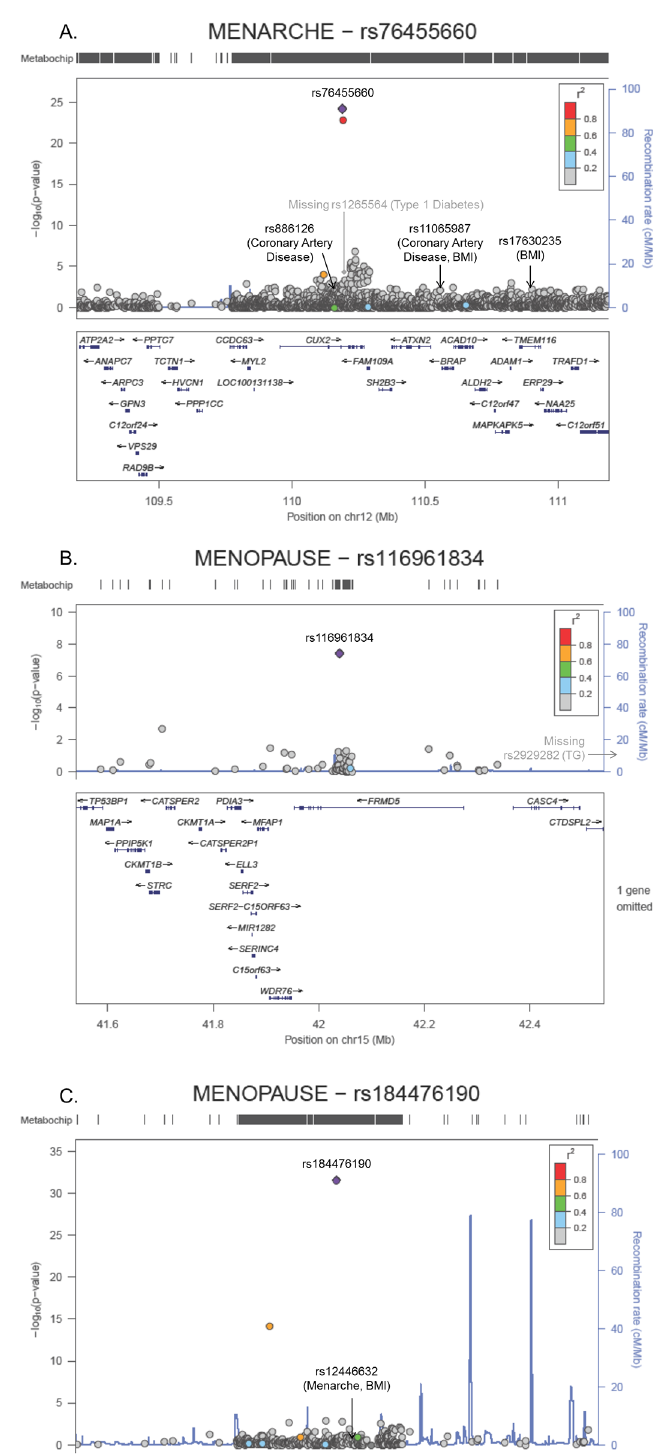
Fig 2. Regional plots of the novel array-wide significant age at menarche (Panel A: CUX2 )and natural menopause loci (Panels B,C: FRMD5 , GPRC5B ) using a modified random-effects trans-ethnic meta-analysis of more than 31,000 women, and showing independence from previously published cardiometabolic SNP associations (shown in gray if missing).